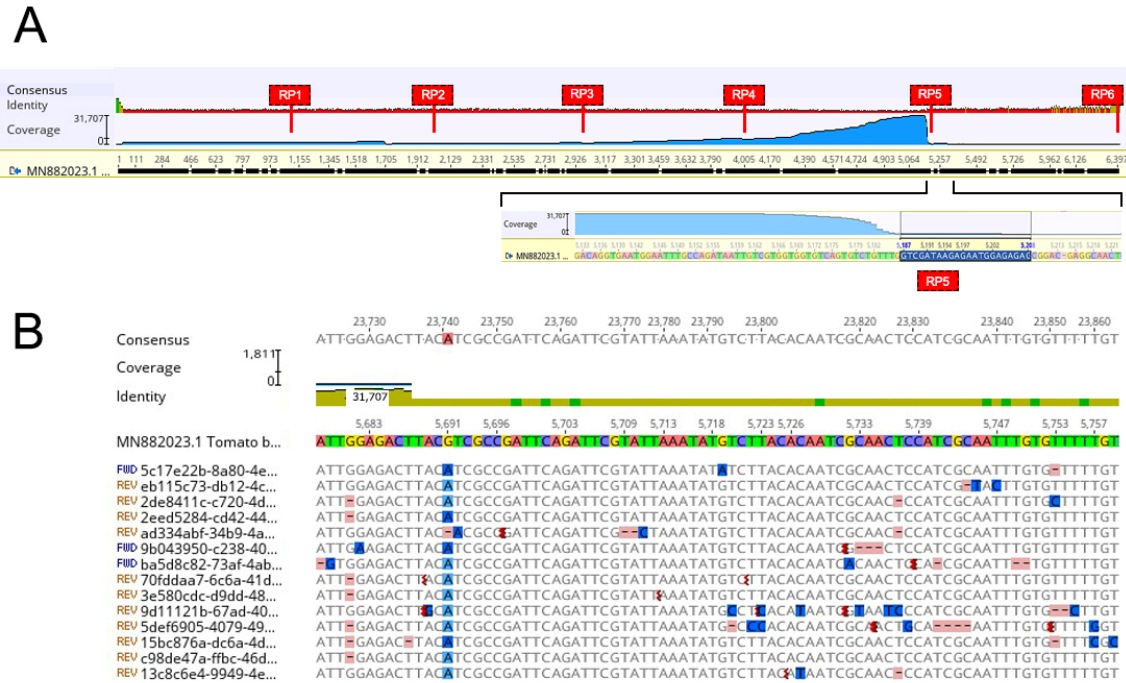
Figure 2. Coverage and nucleotide sequence variability within individual Oxford Nanopore Technology cDNA reads, from virus-infected tomato plants, using tomato brown rugose fruit virus (ToBRFV), Dutch isolate (MN882023.1) as the reference genome. ( A ) Coverage of MinION-derived reads within the full-length sequence of the ToBRFV genome, represented by the blue area. The position of the six reverse primers (RP1-6) on the ToBRFV genome is shown as red labels. In the insert, the detailed position of RP5 complementarity. Vertical bars on the left indicate the maximum coverage of nucleotide positions expressed in X. ( B ) Example of alignment of MinION-derived reads on the ToBRFV genome region 5678–5759. A number of low-frequency individual sequence variations are shown (blue shading). At position 5691 all reads show a consistent sequence variation that indicates a G>A substitution as compared to the reference sequence. Sequence and alignment visualization was performed by Geneious Prime.